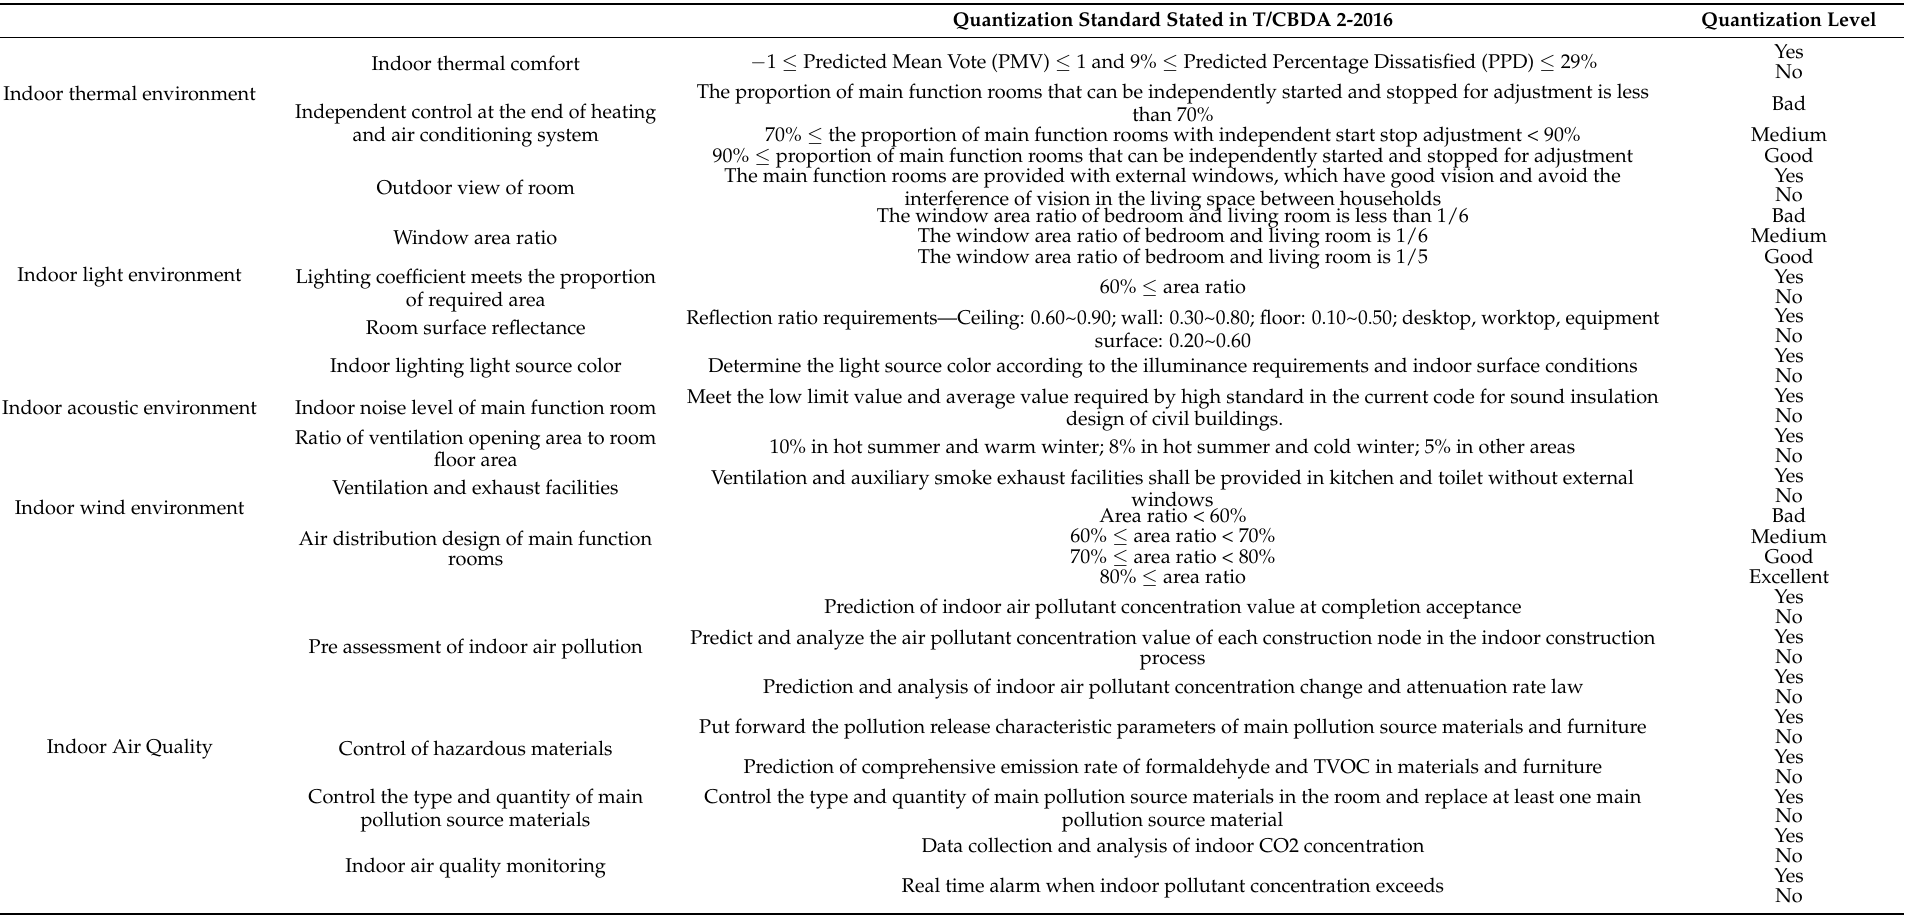
Table 1. The quantitative grade for the index of indoor environmental quality assessment